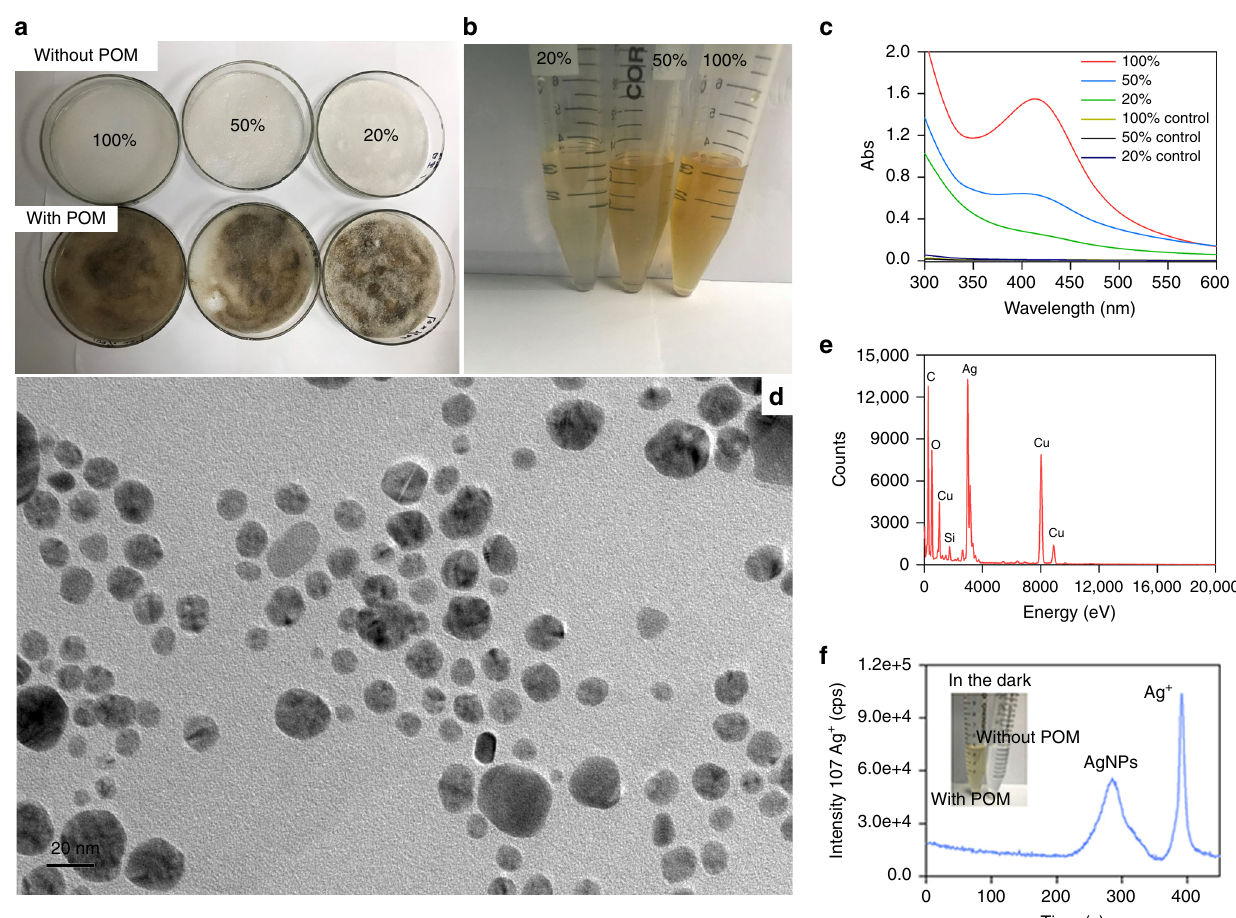
Fig. 1 Silver nanoparticles in sand matrix under natural irradiation. a Representative sand matrix samples without or with particulate organic matter (POM) at 20%, 50%, and 100% humidity under natural irradiation for 10 h at ~30 °C. b Color evolution of samples collected from the sand matrix in the presence of POM under conditions of different humidity. c Characteristic absorbance spectrum of AgNPs recorded by UV – Vis spectra in the supernatants. d TEM image of AgNPs formed in supernatants of samples with water-holding capacity of 100% in a . e EDS analysis of particles in d . f The formation of AgNPs after interaction of Ag + and POM in sand matrix in the dark as revealed by